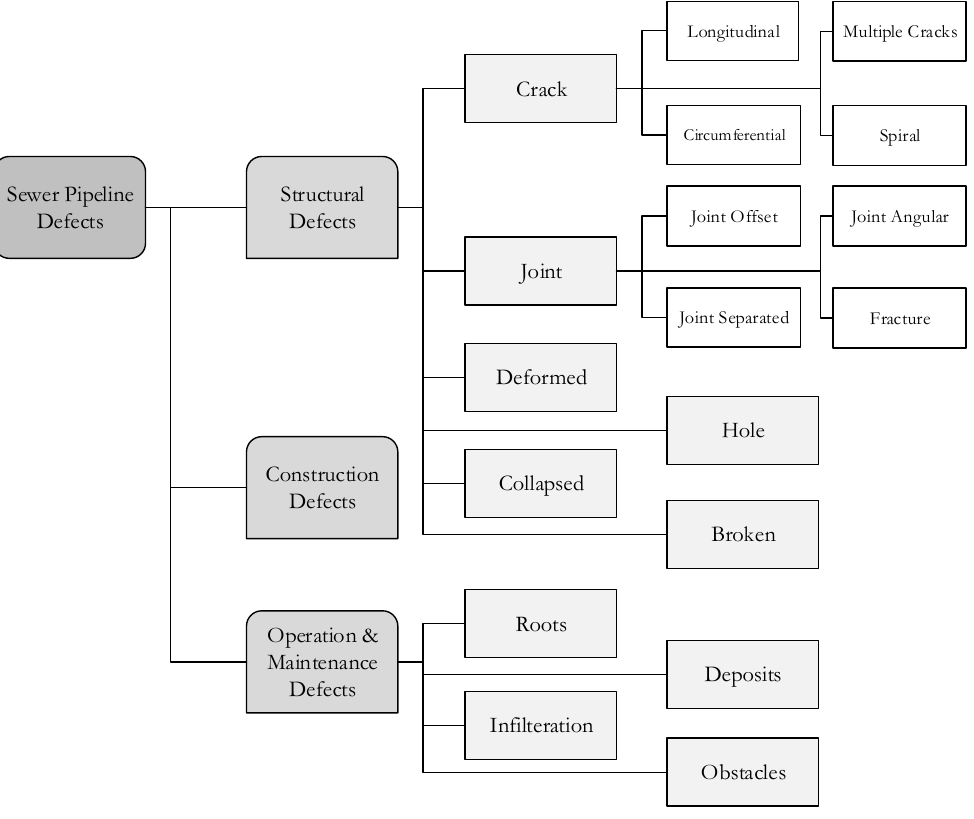
Figure 2. Common sewer pipeline defect classification. Adopted from PACP [7].